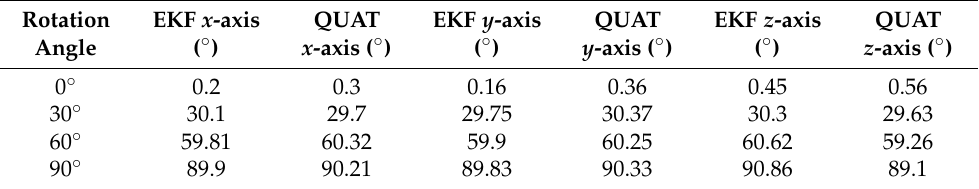
Table 1. Experimental results of attitude